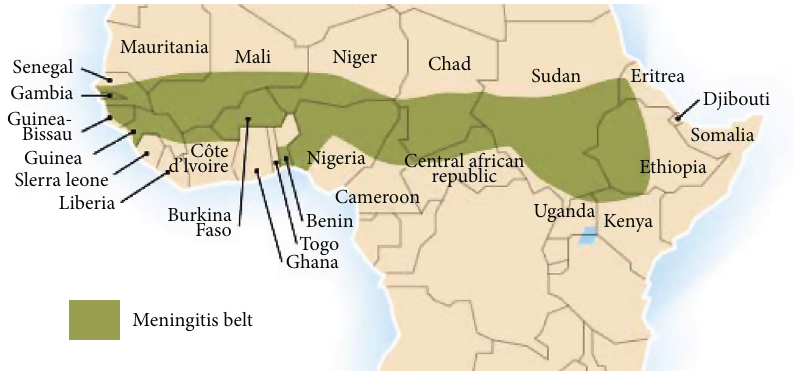
Figure 1: The meningitis belt of sub-Saharan Africa [9]. Meningitis is endemic within the belts, and outbreaks are facilitated by dry winds during the Harmattan season between January and